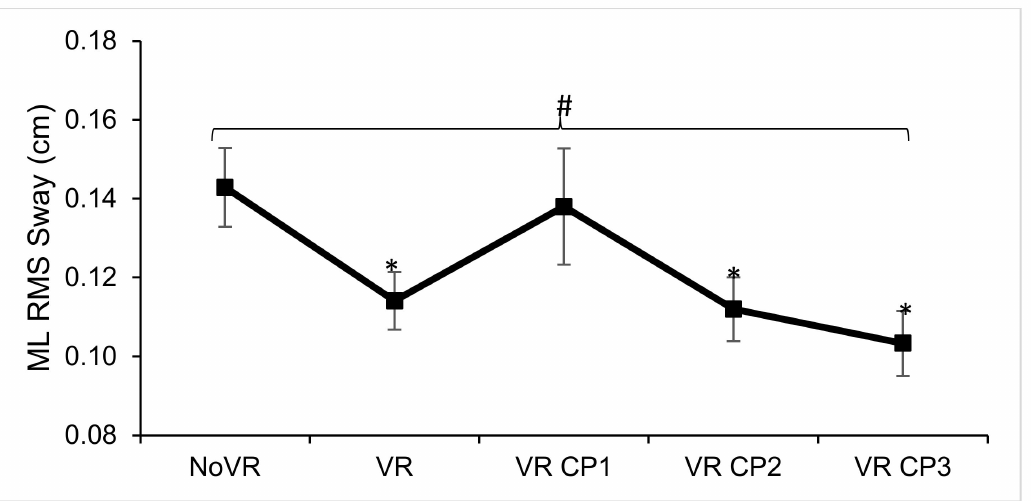
Figure 4. Medial lateral root mean square (ML RMS) sway (cm) during upright bilateral stance with no virtual reality (NoVR), with virtual reality (VR), first trial in virtual environment with room walls closing in (VR CP1), second trial (VR CP2), and third trial (VR CP3). # represents main effect significance and * represents post-hoc pairwise comparison significance. Bars represent standard